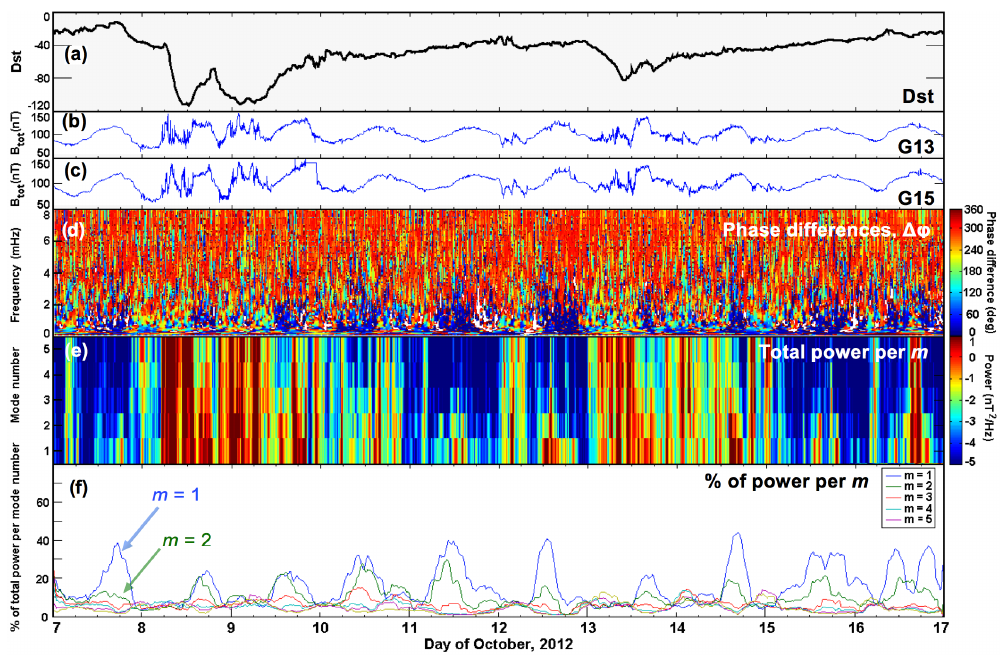
Figure 3. (a) Dst index during 7–17 October 2012; (b) GOES-13 and (c) GOES-15 total magnetic field; (d) cross-spectrogram phase differences between (b) and (c) ; (e) power per m number; (f) fraction of the total power in each of the wavenumbers m = 1 to 5.